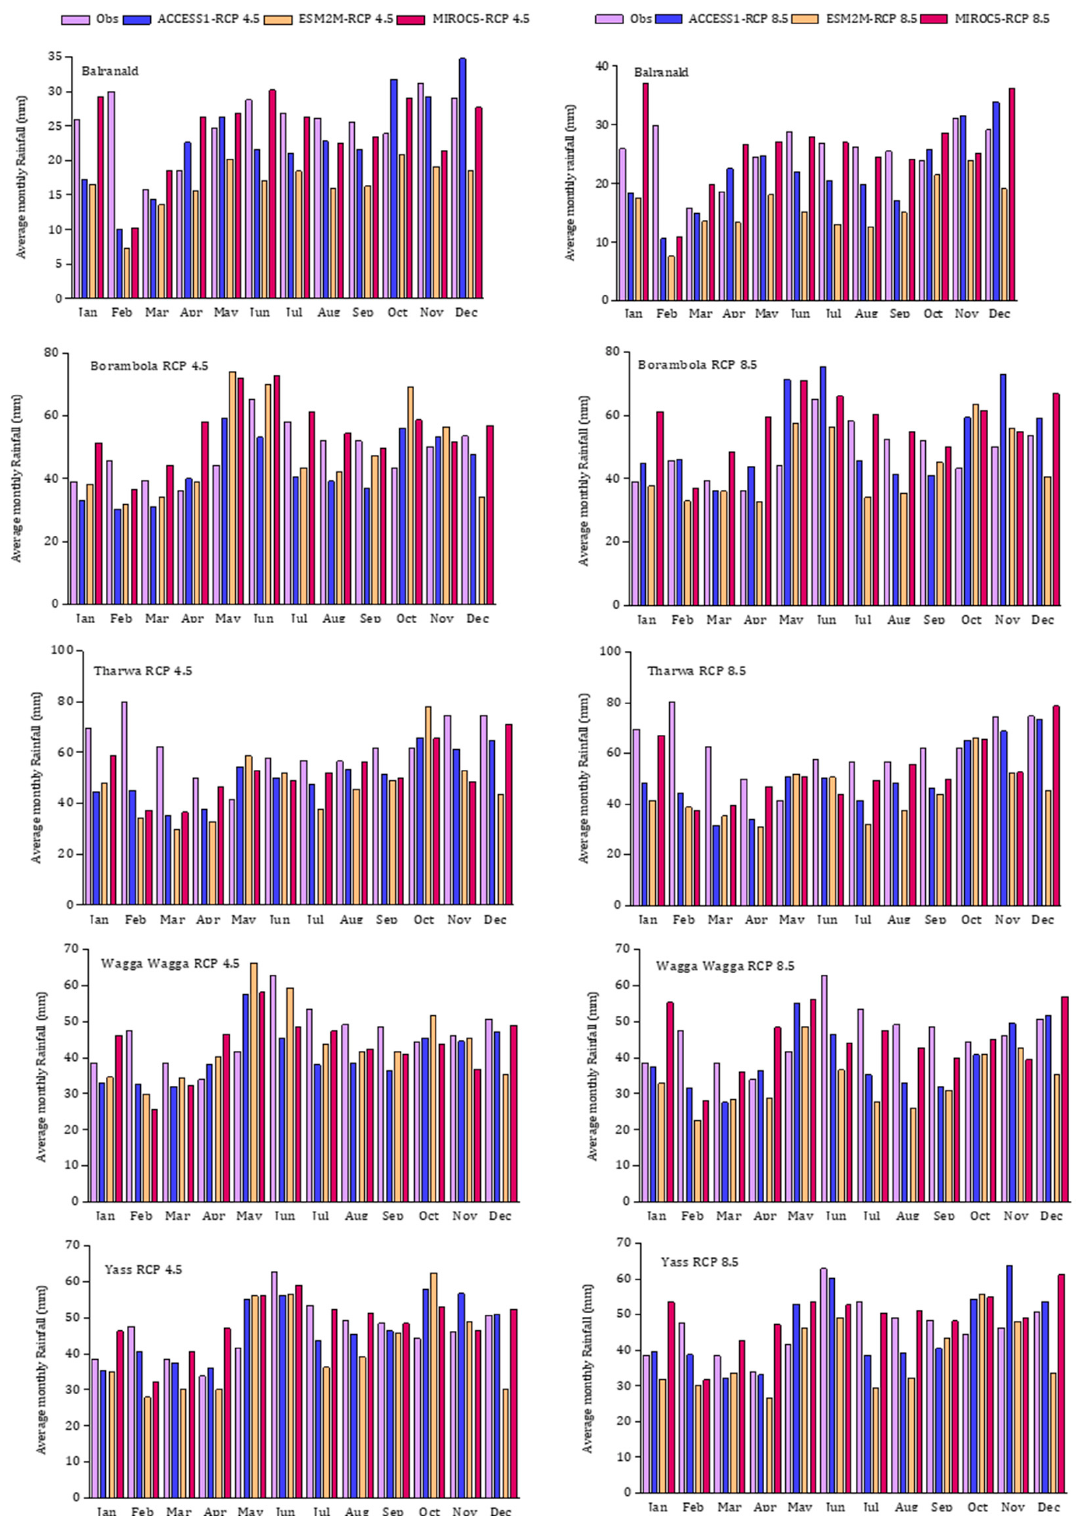
Figure 7. Predicted and observed monthly average rainfall for sub-catchments in the Murrumbidgee River basin for the period 2016–2035 under the RCP 4.5 climate scenario.